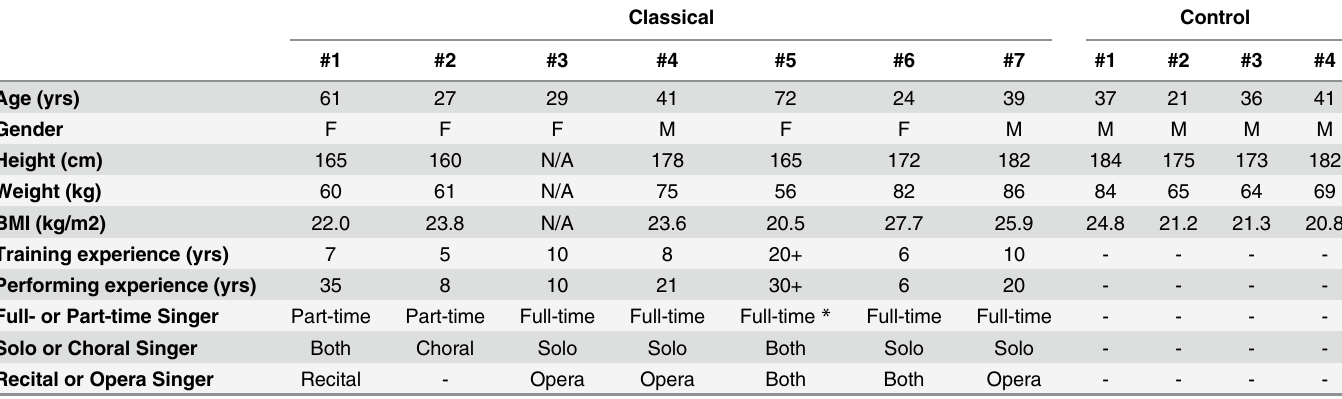
Table 1. Anthropometric parameters and information about formal training and performing experience from classical singers and untrained indi- viduals (controls).